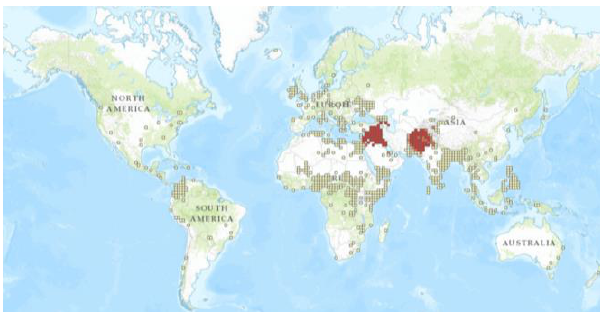
Figure 5 Hot spot analysis of worldwide terrorism events in 2014